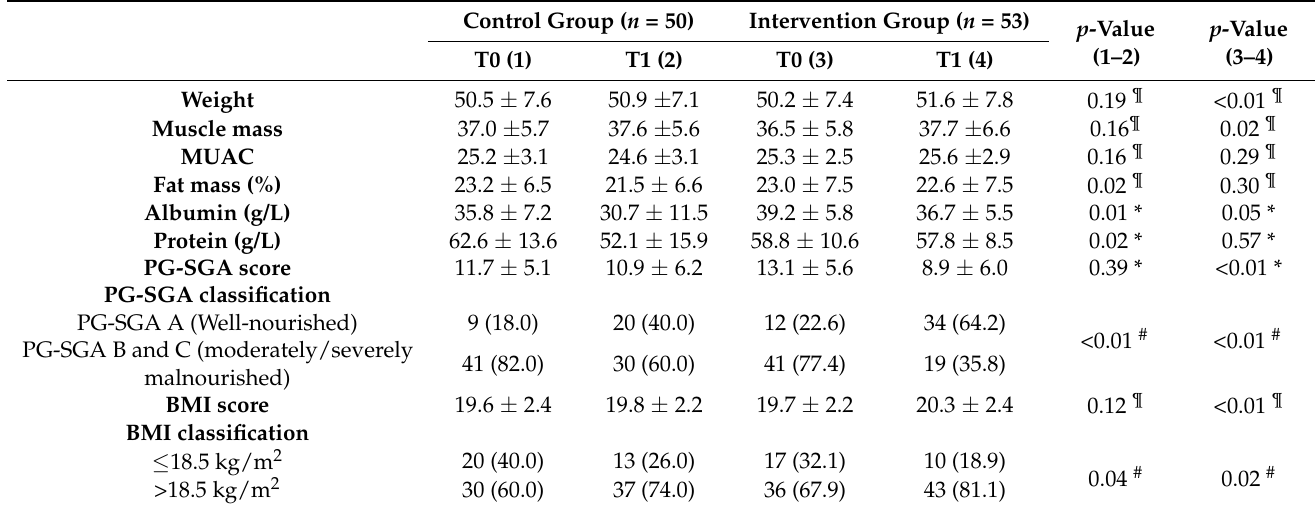
Table 2. Nutritional status of participants before and after intervention of control and treated group. Control Group ( n =